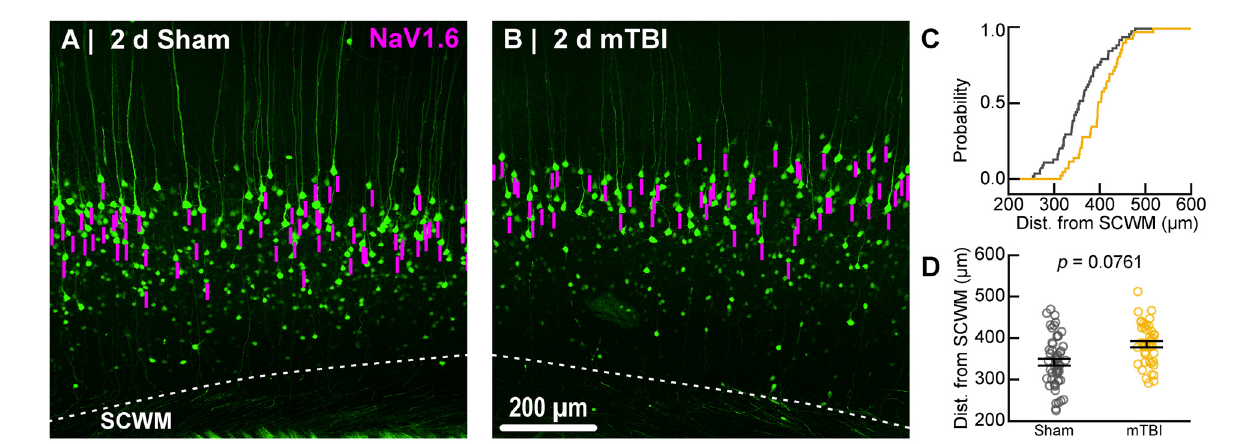
FIGURE 7 | Sampling distribution of intact YFP+ pyramidal neurons for NaV1.6 quantitative analysis. (A,B) Superimposed maximum intensity projections of 10 × overview images for sham (A) and mTBI (B) . The intact YFP+ pyramidal neuron sampling distribution (magenta bars) with respect to the SCWM appeared slightly asymmetric, with mTBI having several samples located more superficially (upper right aspect). (C) Cumulative frequency distribution plot showing mTBI (gold) samples are shifted toward increased distance from SCWM compared to sham (gray). (D) Quantitative analysis confirmed revealed there was no statistically significant difference in sampling. Statistics: multilevel analysis with animals as a random variable. Data summarized with means and SEM error bars.